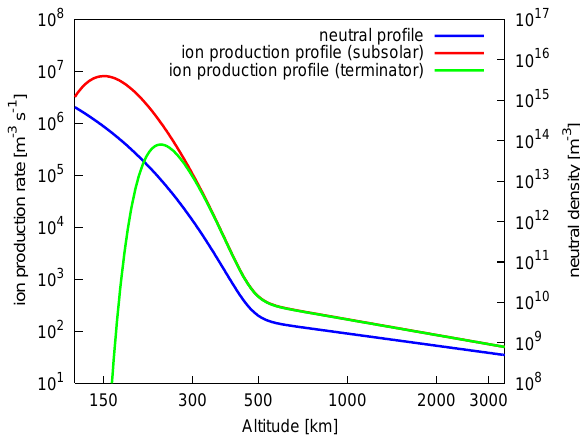
Fig. 5. Neutral gas density (blue line), the ion production rate (red line in subsolar direction and green line at the terminator) of oxygen as a function of altitude at solar minimum ( ν = 1 · 10 − 7 s − 1 ). Note the two different axis